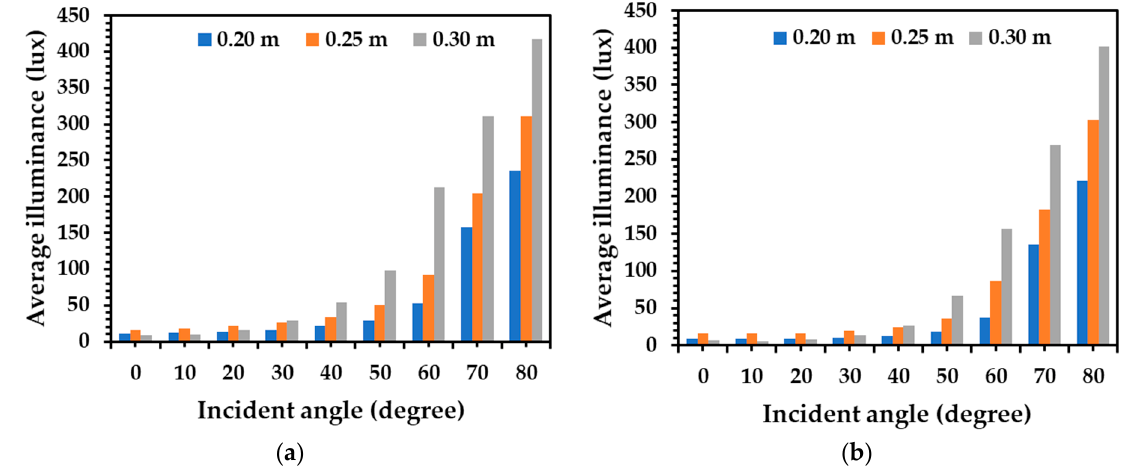
Figure 14. Average internal illuminance contours on the floor for the ( a ) aluminum alloy and ( b ) zinc alloy light tubes.